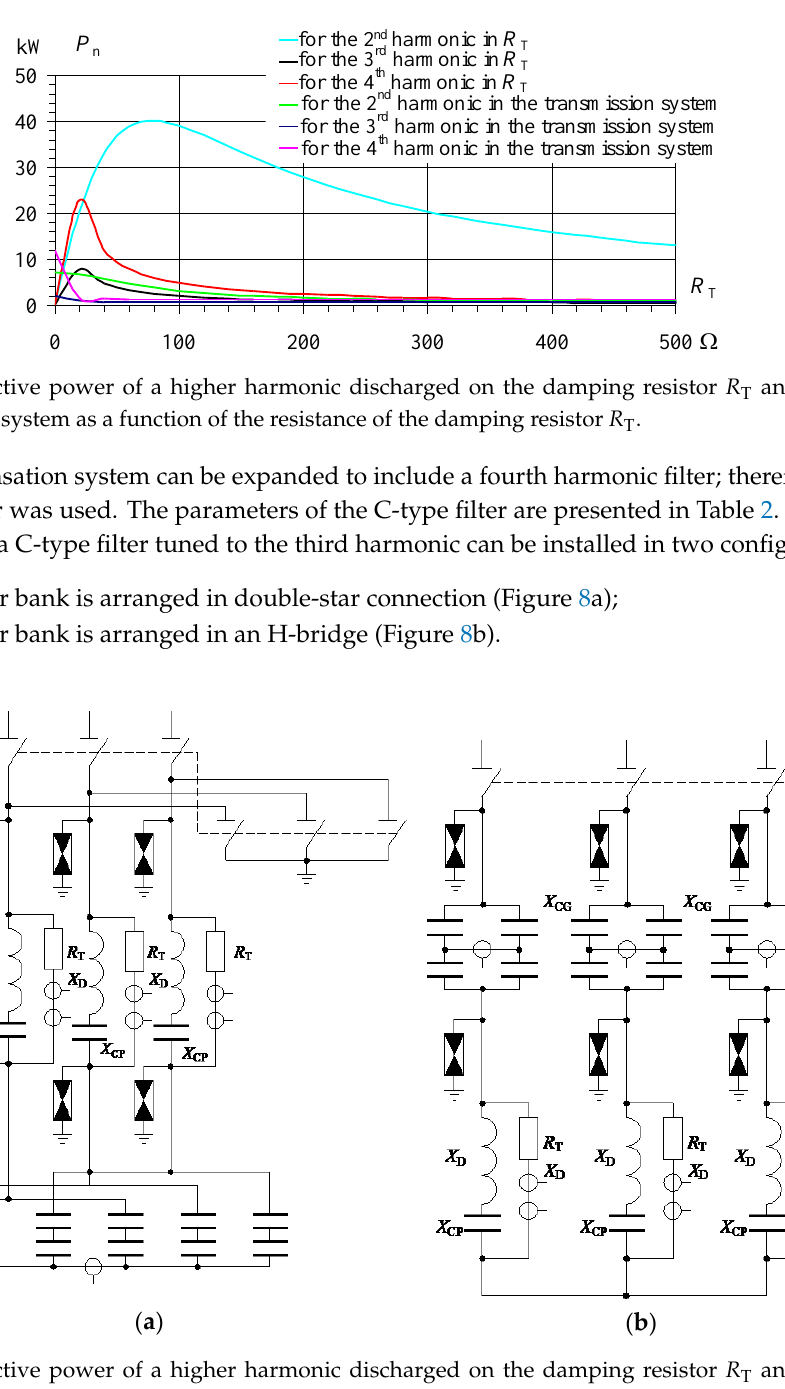
Figure 7. Active power of a higher harmonic discharged on the damping resistor R T and in the transmission system as a function of the resistance of the damping resistor R T .